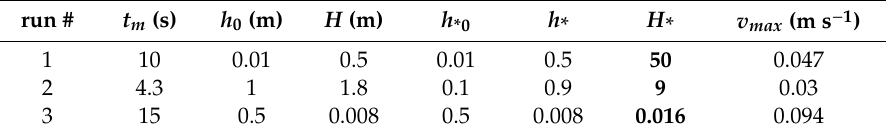
Table 5. For the three runs, hydraulic parameters of the water tank. Bold values refer to H ∗ input parameter considered in Equations